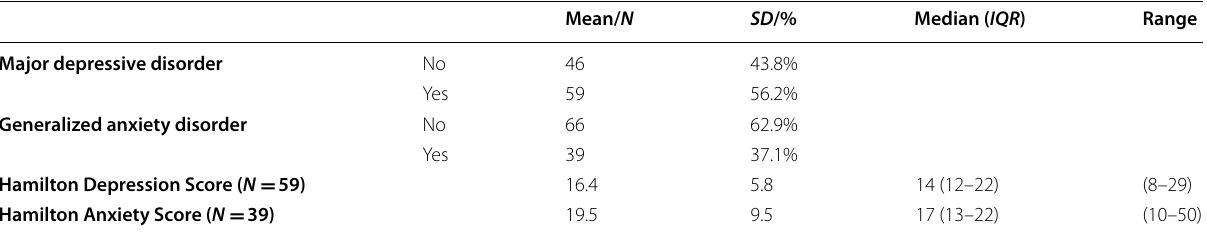
Table 2 The prevalence of major depressive disorder and generalized anxiety disorder